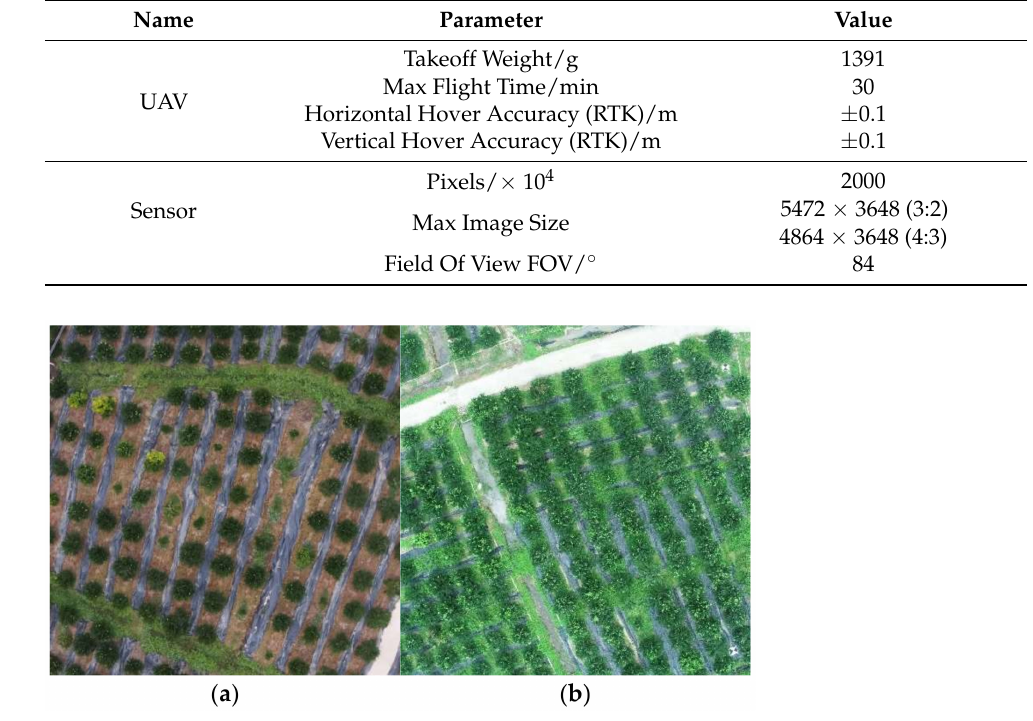
Figure 3. Orchard remote sensing image datasets: ( a ) Scene 1: after weeding, ( b ) Scene 2: before weeding.